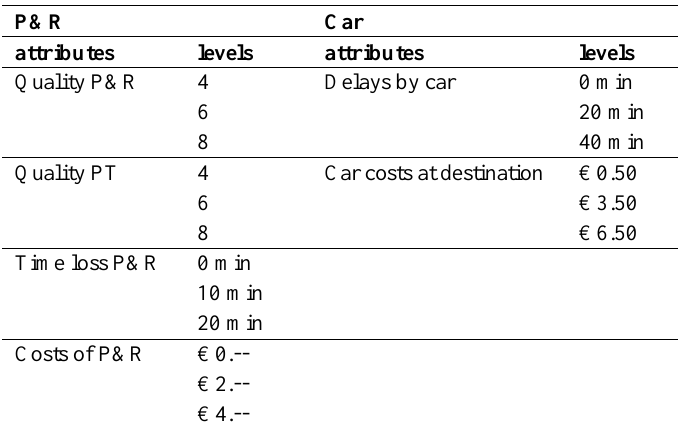
Table 1. Selected attributes and their